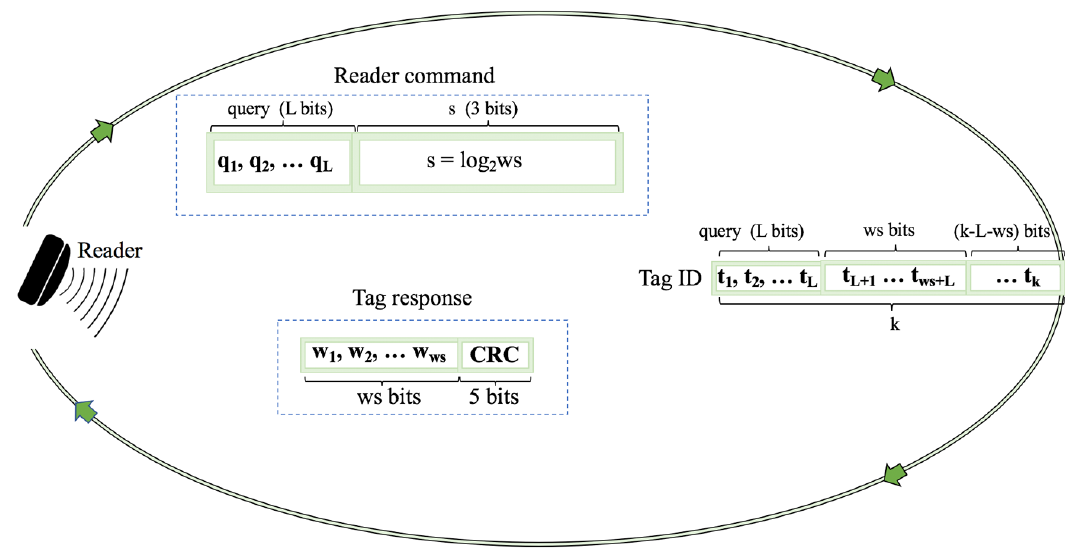
Figure 6. Format of the reader command and tag responses of the FQwT